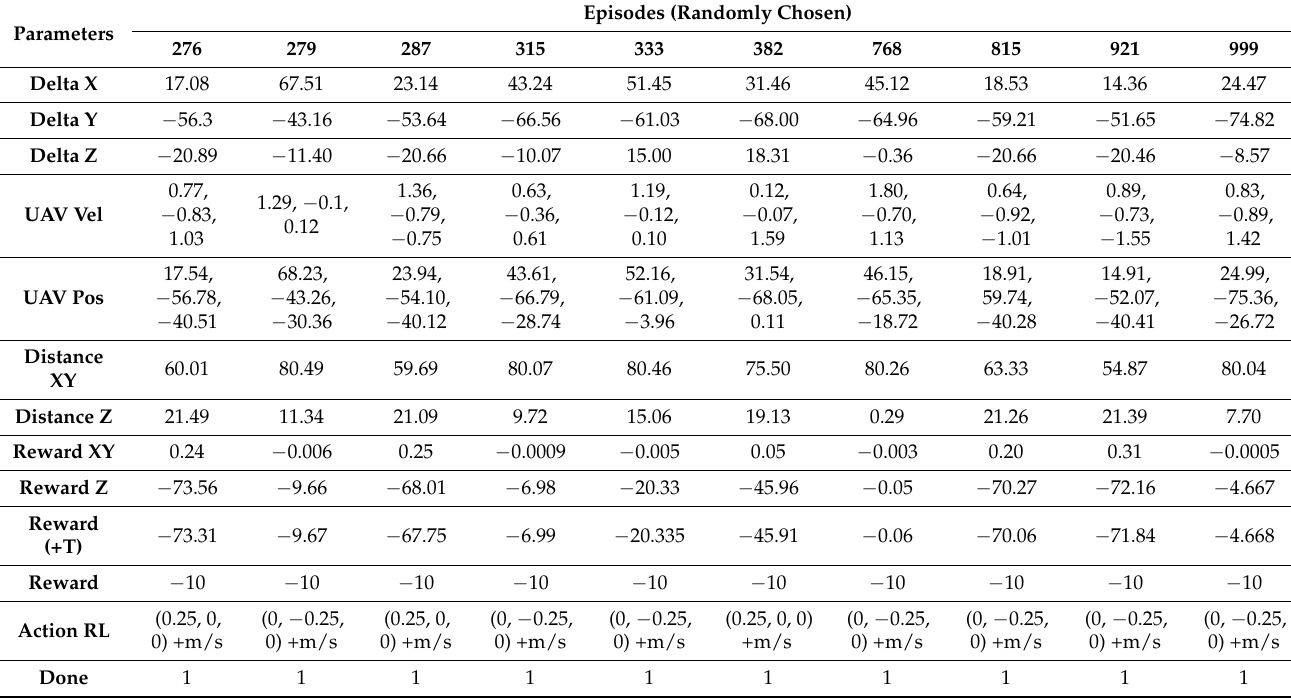
Table 1. DQN agent drone testing output parameters.